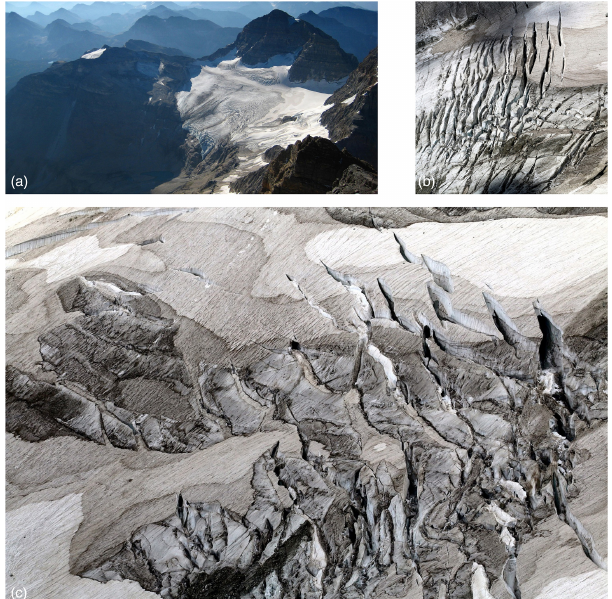
Figure 11. (a) A glacier on Mount Assiniboine, British Columbia, Canada seen during a field trip in the framework of the SEG 2009 Summer Research Workshop on “CO 2 Sequestration Geophysics”. (b, c) A minor glacier in the Mont Blanc group (Italy) seen during a field trip in the frame of the “Near Surface Geoscience 2015 – 21st European Meeting of Environmental and Engineering Geophysics”